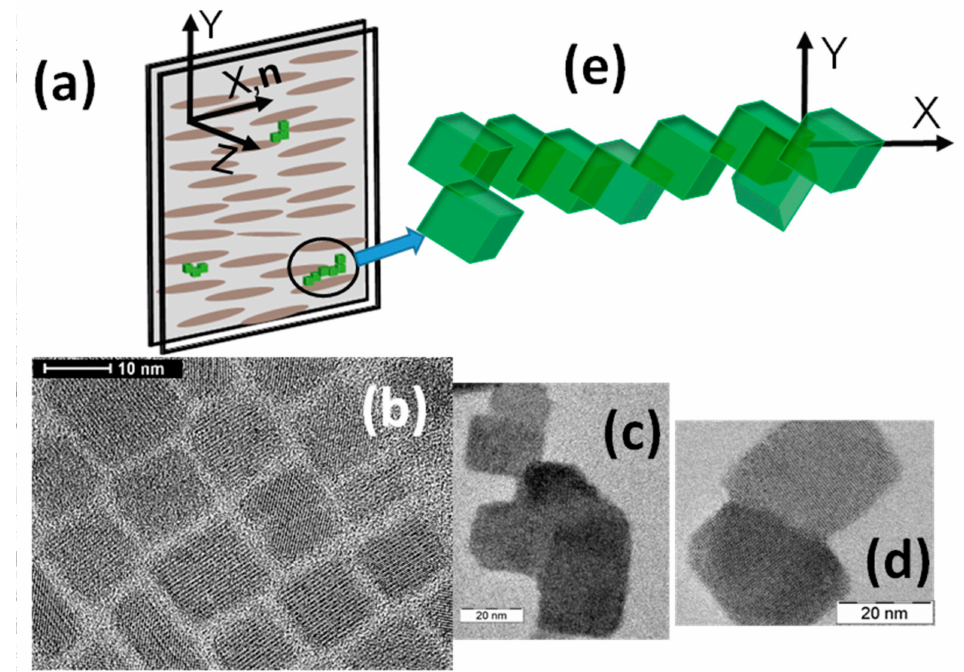
Figure 1. TEM images of ( a ) the as-synthesized CsPbBr 3 quantum dots exhibiting cuboidal architecture. When dispersed in the nematic LC, the neighbouring cuboids organize along their body diagonal (see images b and c ) and develop a tendency to form linear assemblies along the director direction, schematically shown in ( d ); the TEM images are adapted from